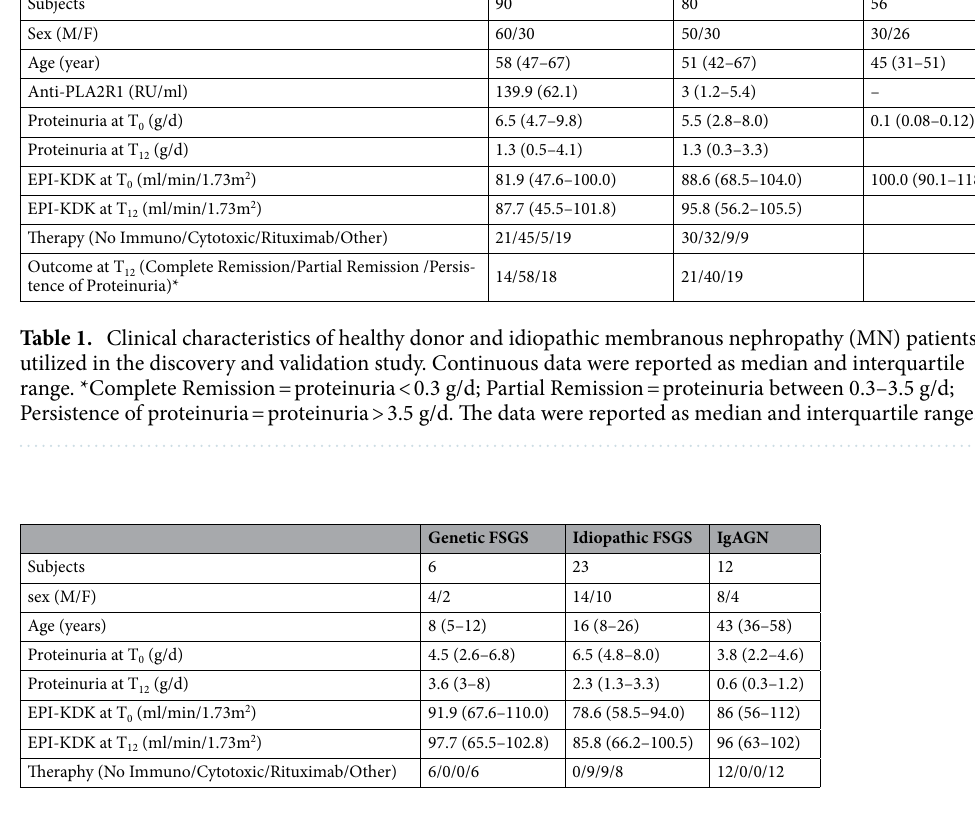
Table 2. Clinical characteristics of different patient subsets utilizedin this study. Continuous data were reported as median and interquartile range.